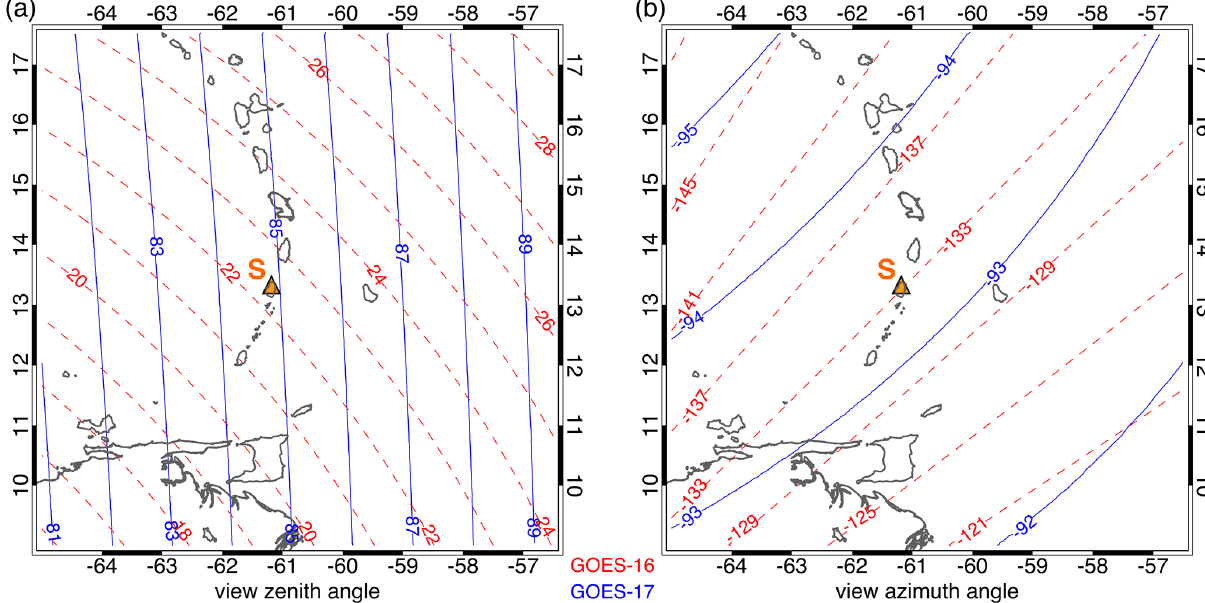
Figure 1. GOES-16 (dashed red) and GOES-17 (solid blue) (a) view zenith angle and (b) view azimuth angle for La Soufrière (orange triangle and letter “S”). The negative view azimuth angle is measured counterclockwise from north.